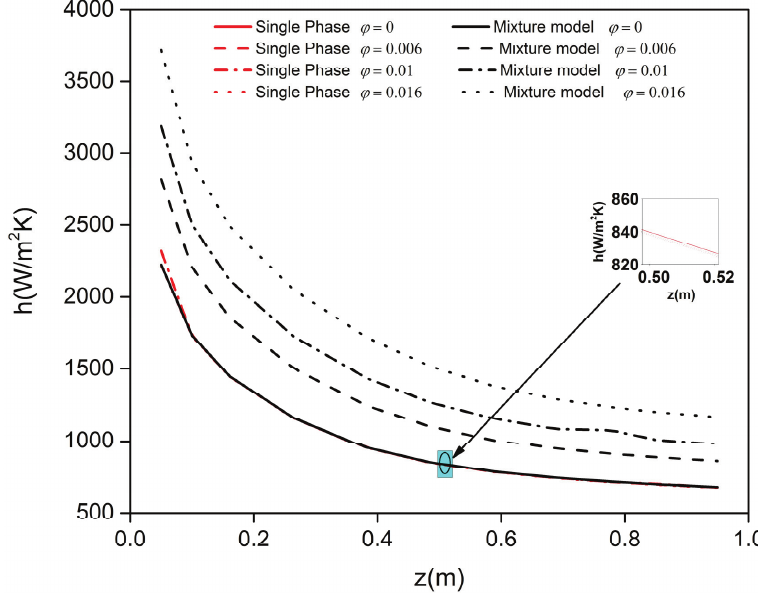
Figure 5. Local heat transfer coefficient obtained for Re = 1600, d np = 42 nm and Al 2 O 3 -water based nanofluids: comparison between the single-phase and mixture models with temperature-dependent